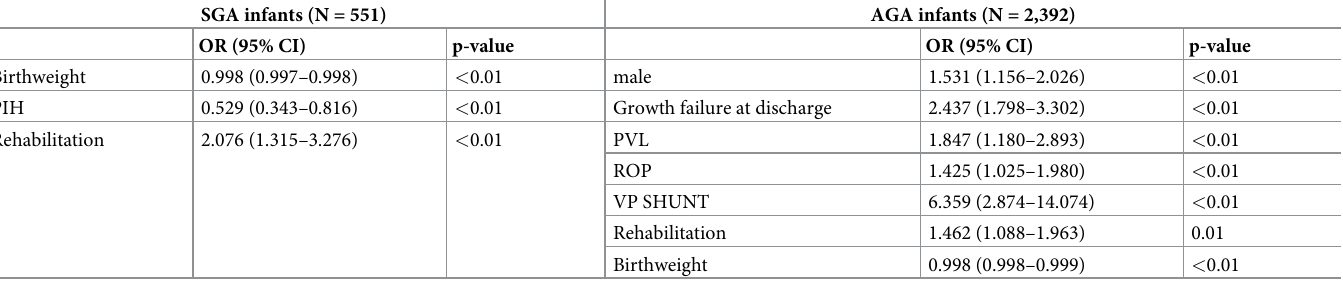
Table 3. Independent risk factors for growth failure at follow-up 1 among the infants with small for gestational age and appropriate for gestational age analyzed by multivariate analysis.